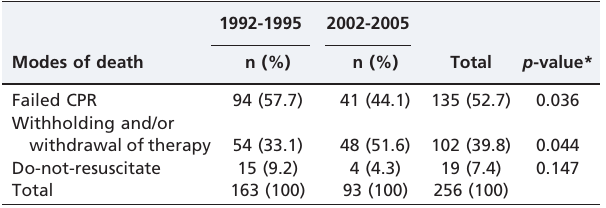
Table 1 - Modes of death in the NICU in the two cohorts.